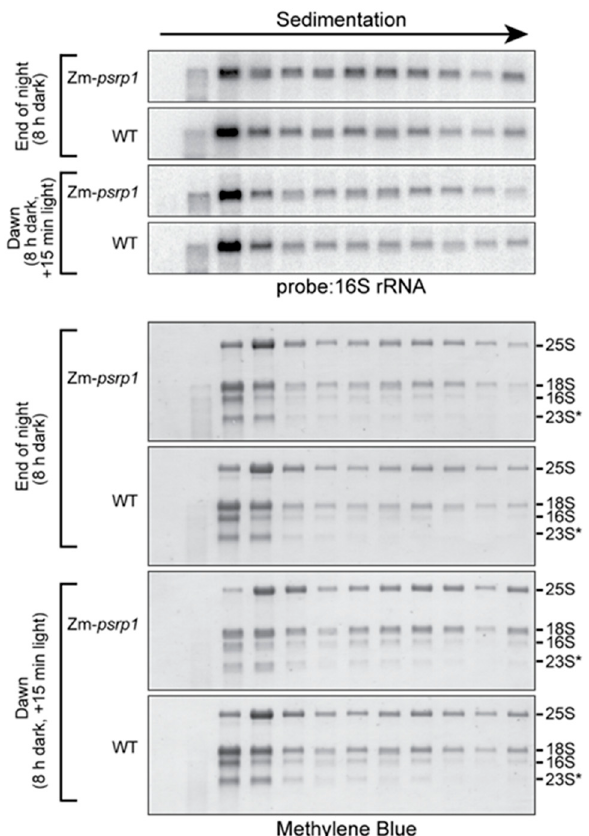
Figure 5. Sucrose gradient fractionation of polysomes in WT and Zm- psrp1-2 seedling leaf extract at the end of night (8 h dark) and after 15 min of illumination at dawn. These experiments differed from those in Figure 2 by the inclusion of heparin and chloramphenicol to maintain polysome integrity, and by the use of centrifugation conditions that resolve polysomes rather than free ribosomal subunits. An equal proportion of the RNA recovered from each fraction was analyzed by RNA gel blot hybridization, using a probe specific for the chloroplast 16S rRNA (top). Images of the same blots stained with methylene blue are shown below to illustrate the distribution of all rRNAs in the gradient. 25S and 18S are cytosolic rRNAs, and 16S and 23S* are chloroplast rRNAs. The WT and mutant tissue came from siblings on the same ear.